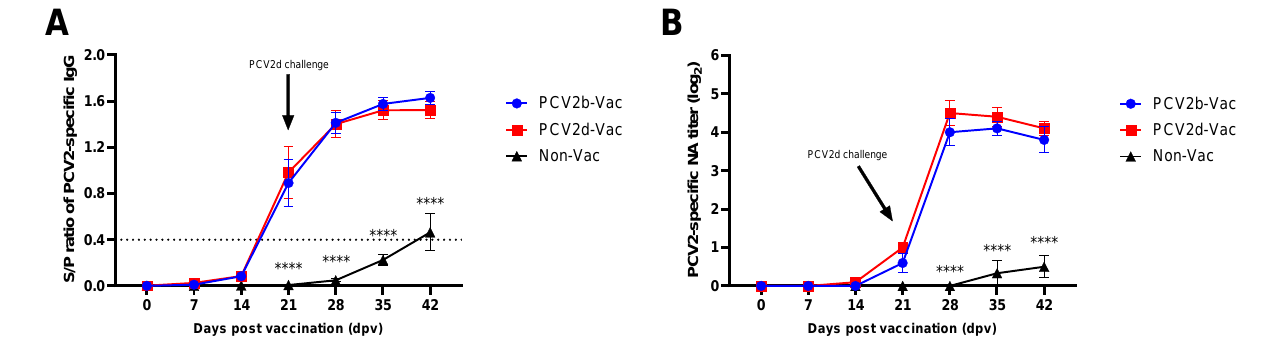
Figure 6. Antibody responses in pigs after immunization with different PCV2 vaccines in the vaccine efficacy study (Experiment 2). The levels of PCV2-specific IgG antibodies ( A ) and neutralizing antibodies ( B ) were detected at the indicated timepoints. All data are presented as group means ± SEM. Statistically significant differences between Non-Vac and vaccinated groups within the timepoint are indicated at p < 0.0001 (****).